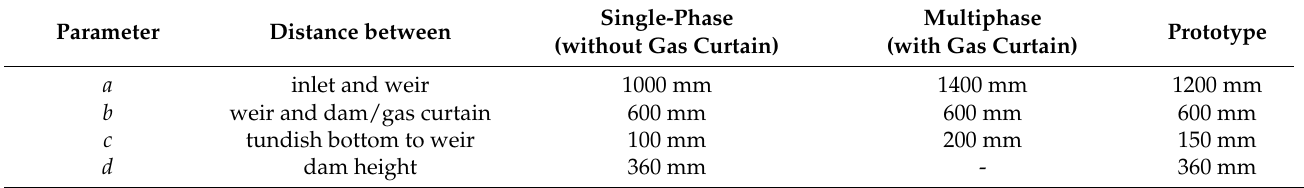
Figure 3. ( a ) Schematic diagram and ( b ) plexiglass model for water model of tundish. Table 3. Optimized geometrical parameters of flow control devices in tundish.